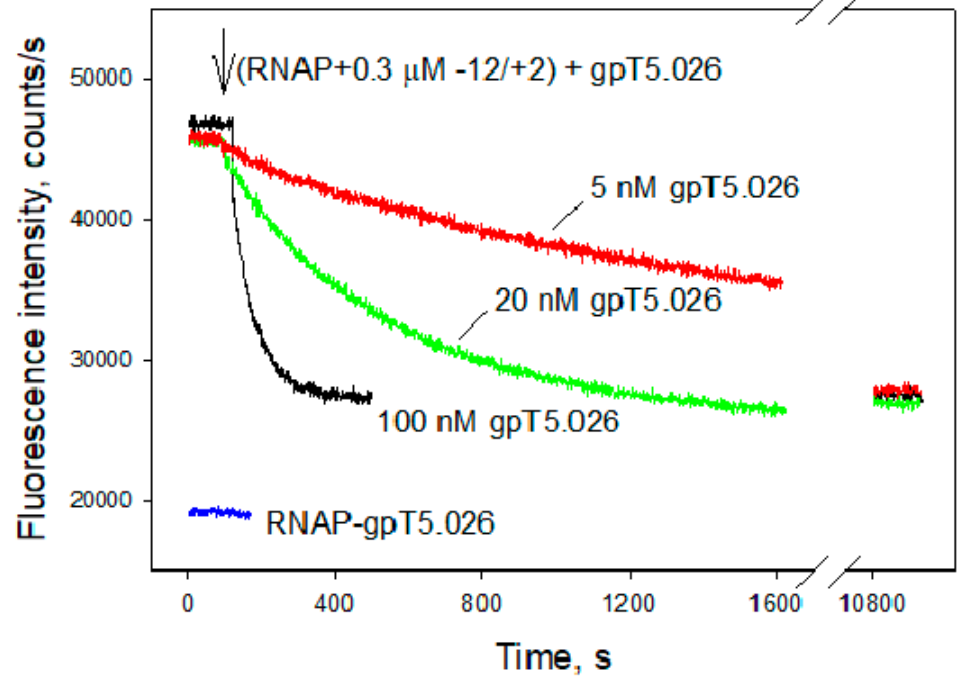
Figure 8. Evaluation of gpT5.026 a ffi nity to RNAP by the RNAP beacon assay. Three samples containing 1 nM [211Cys-TMR] σ 70 RNAP and 0.3 µ M − 12 /+ 2 oligonucleotide were incubated for 5 min. Then 100, 20, and 5 nM gpT5.026 were added to the samples, and fluorescence intensity was monitored over